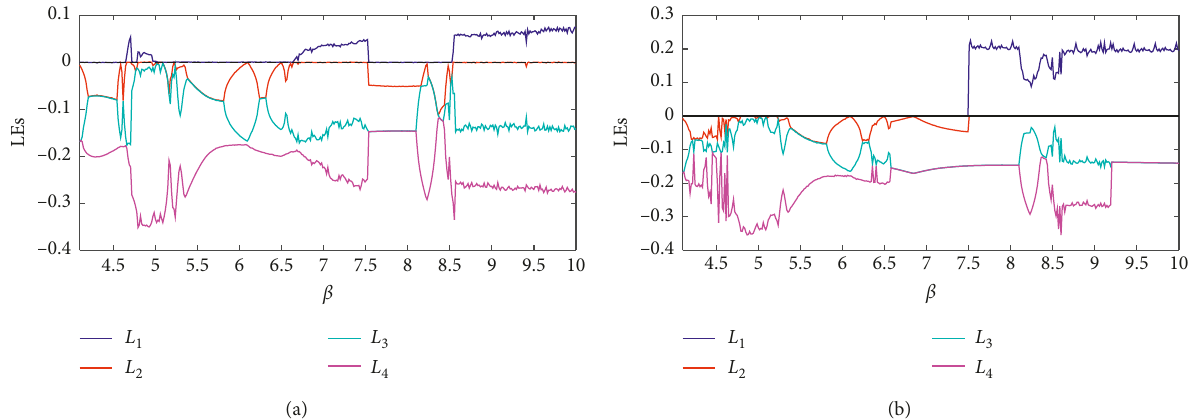
Figure 5: Lyapunov exponents for (a) forward continuation and (b) backward continuation.